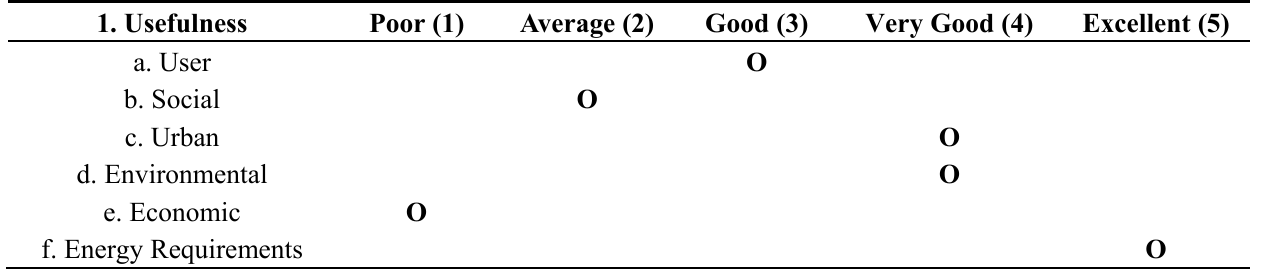
Table 2. Technology X scoring